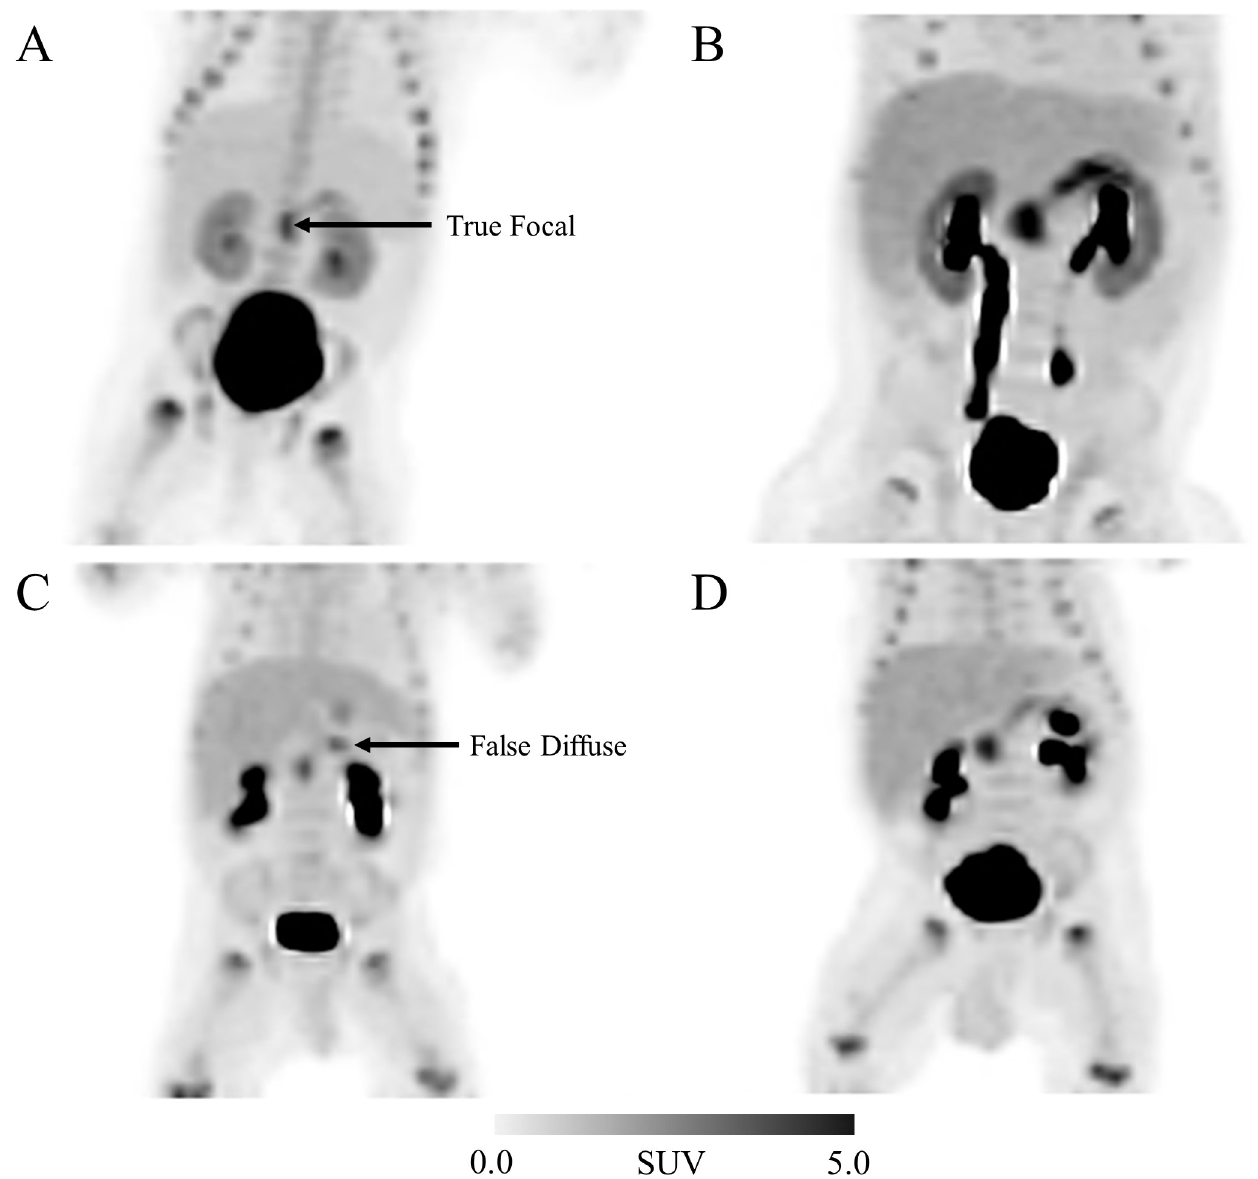
Fig 2. Maximum Intensity Projections (MIP) images of four subjects prepared from the image set acquired 30 minutes post [ 18 F]Fluoro-L-DOPA administration. The four panels represent the following scenarios relating to the imaging analysis presented here and pathological results: A) focal disease confirmed pathologically, ID # 25, B) diffuse disease confirmed pathologically, ID #13, C) disagreement between imaging (diffuse) and pathology (focal), ID # 26, and D) disagreement between imaging (focal) and pathology (diffuse), ID #19.